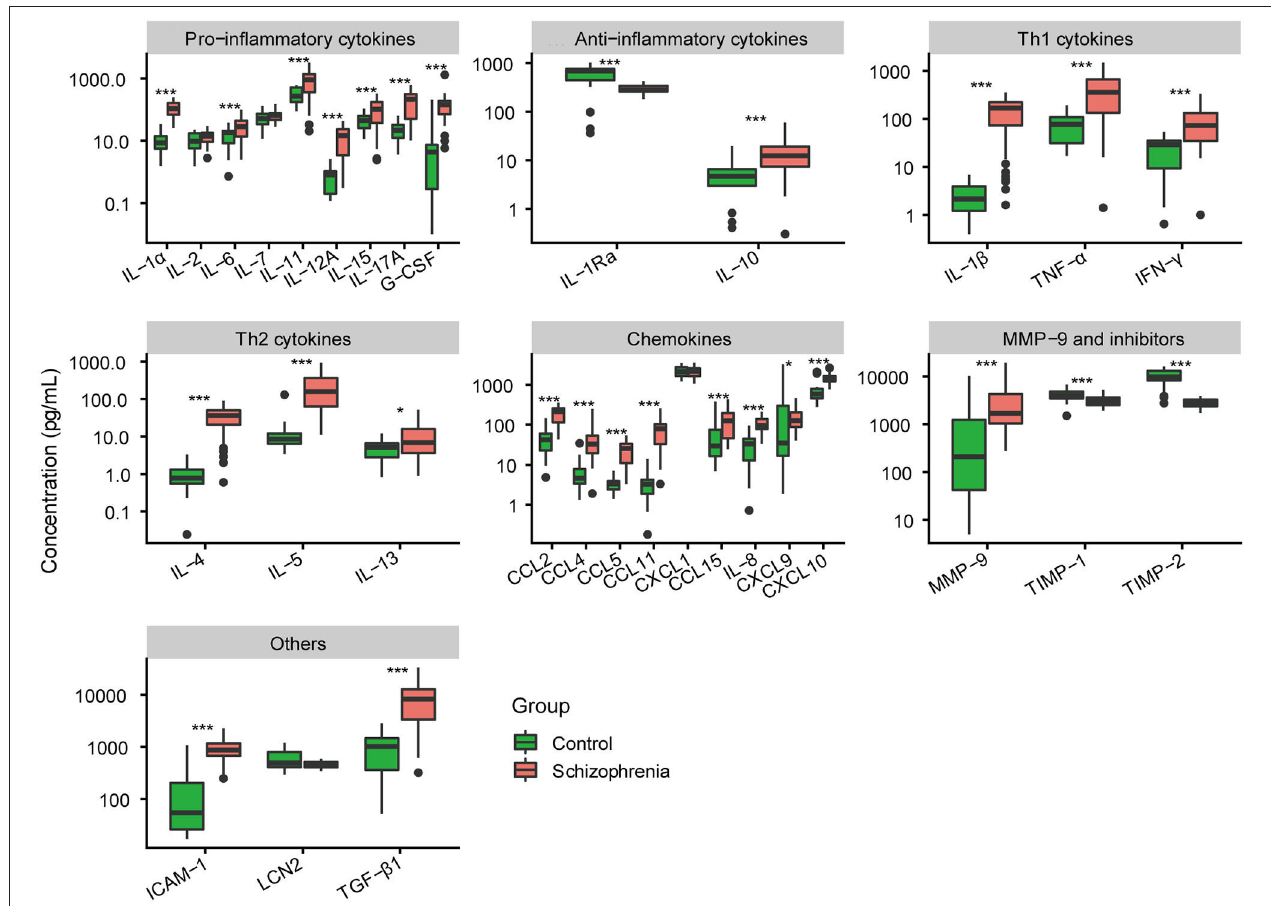
FIGURE 2 | Comparative analysis of expression level of 32 cytokines in tears between normal controls and schizophrenia group . * P < 0.05; *** P <